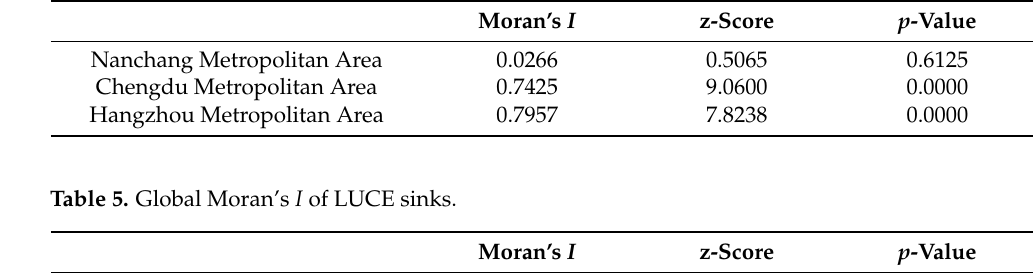
Table 4. Global Moran’s I of LUCE sources.